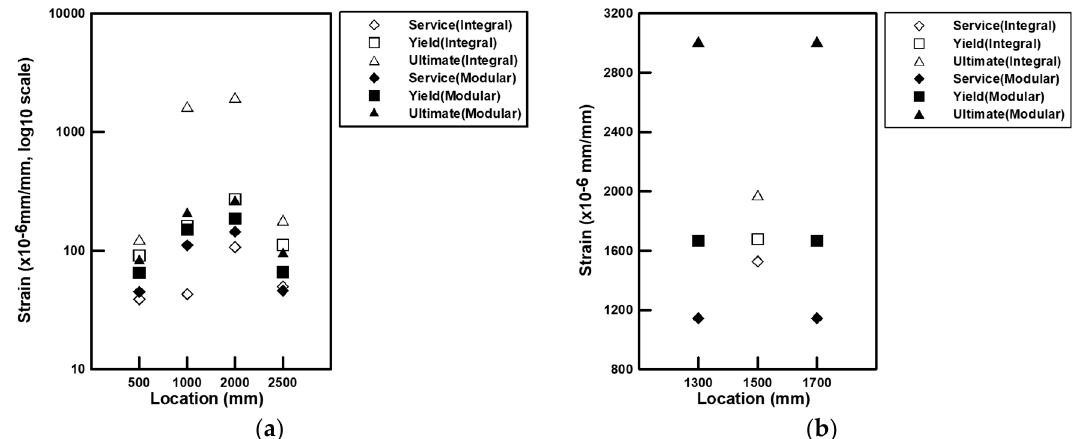
Figure 8. Strain change for each load stage: ( a ) measured strain; ( b ) estimated strain by EC2 Part.1-1.